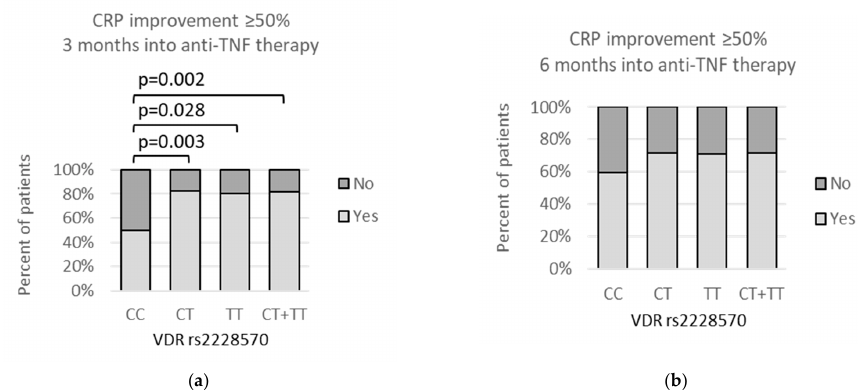
Figure 4. Relationships between VDR rs2228570 genetic variants and percent of patients achieving CRP improvement of ≥ 50% after ( a ) 3 months of anti-TNF therapy and ( b ) 6 months after beginning of the treatment. The following statistically significant associations were found: ( a ) CC vs. CT , p = 0.003, OR(95%CI) = 0.21 (0.08 to 0.59); CC vs. TT , p = 0.028, OR(95%CI) = 0.25 (0.08 to 0.81); and CC vs. CT + TT , p = 0.002, OR(95%CI) = 0.22 (0.09 to 0.59). Analysis was performed using Fisher‘s exact test. As for the time point of 6 months after beginning of the treatment, the rs1544410 AA genotype was statistically more often observed among individuals who achieved CRP improvement equal to or higher than 75%, as shown by the dominant ( AA vs. AG + GG : 12/15 (80%) vs. 42/87 (48.3%); p = 0.027) and the codominant ( AA vs. AG : 12/15 (80%) vs. 22/46 (47.8%); p = 0.038) model (Figure 5b).